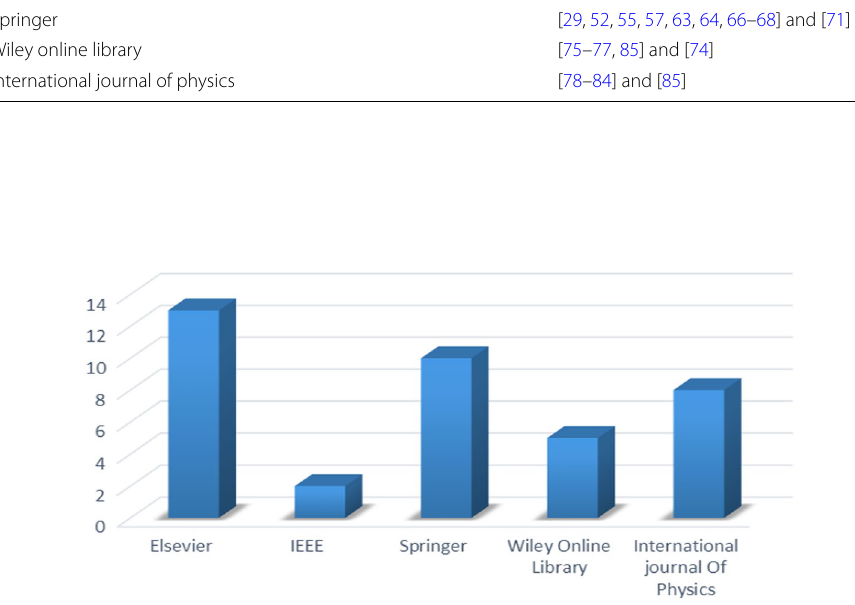
Fig. 4 Chart based on the journal